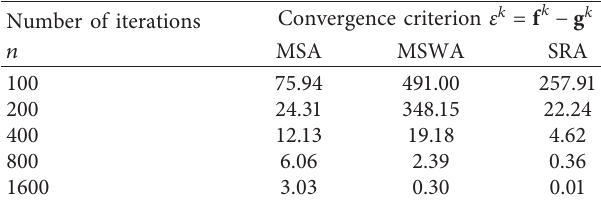
Table 3: Computational efficiency of MSA, MSWA, and SRA. Number of